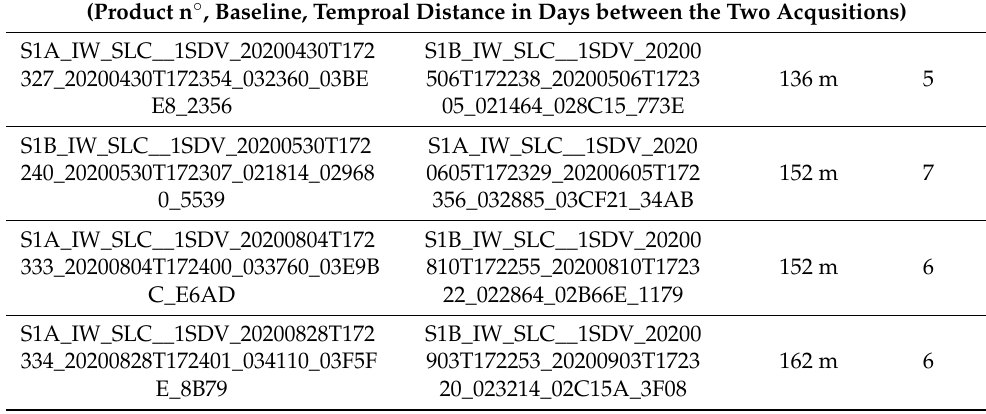
Table 4. SAR S1 images pairs with the distance baseline and